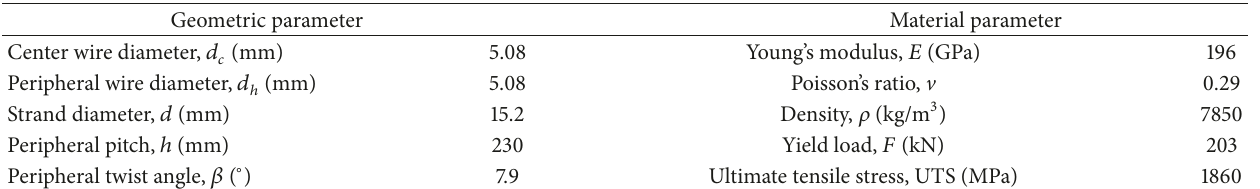
Table 1: Strand geometric and material parameters adopted for numerical analysis.